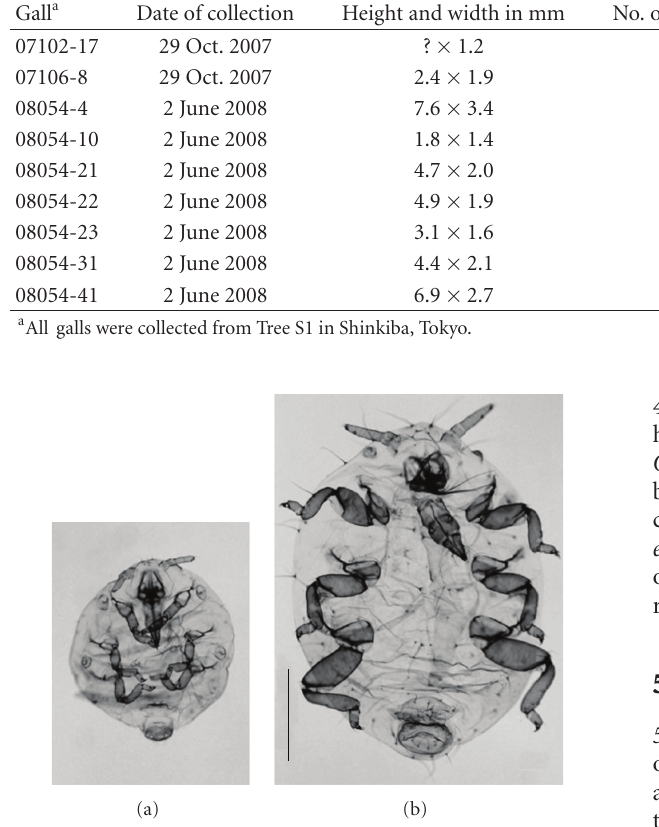
Figure 5: Adults of Nipponaphis monzeni in young galls: fundatrix (a) and thick-legged aptera (second generation) (b). Note the di ff erence in size between them (shown at the same magnification). Scale bar: